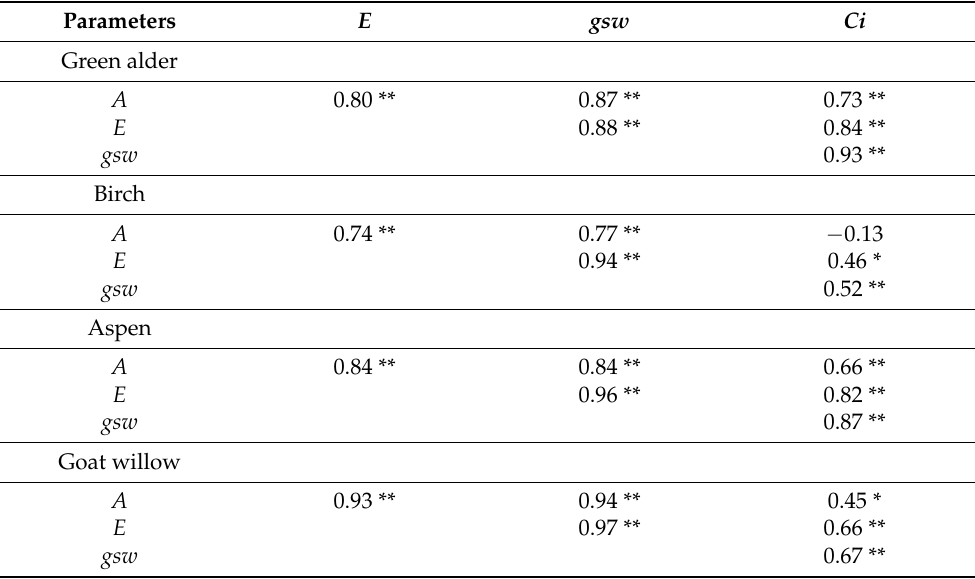
Table 2. Pearson correlation coefficients for relationships between gas exchange parameters ( A –net photosynthetic rate, E –transpiration rate, gsw –stomatal conductance, Ci –intercellular CO 2